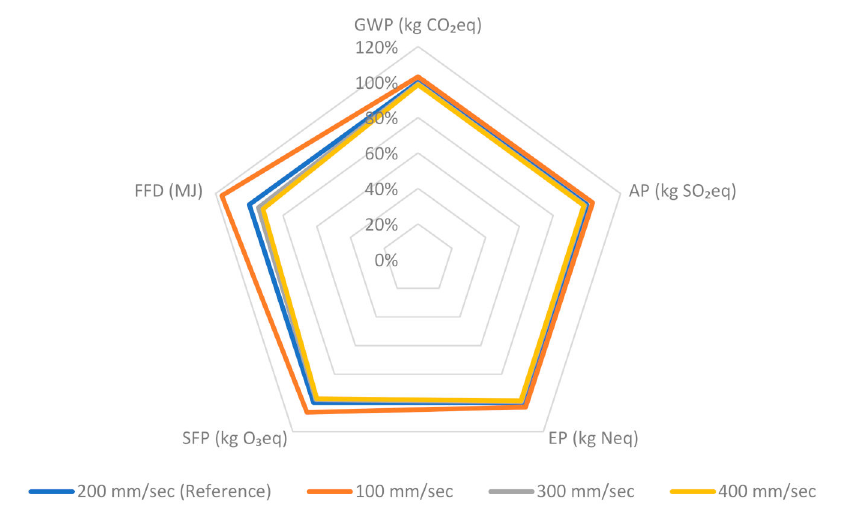
Figure 13. Sensitivity analysis results of using di ff erent printing speed. Table 10. E ff ect of the printing speed on the di ff erent environmental impact